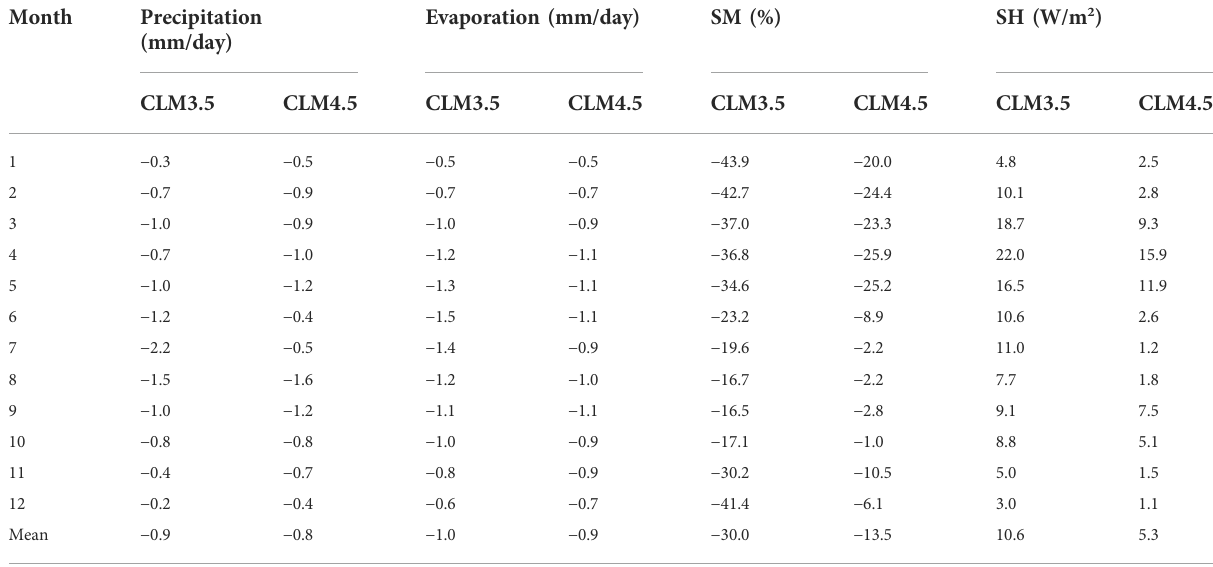
TABLE 5 Differences in hydrometeorological elements in the UYRB between the CLMs (CLM3.5 and CLM4.5) and BATS schemes. Month Precipitation